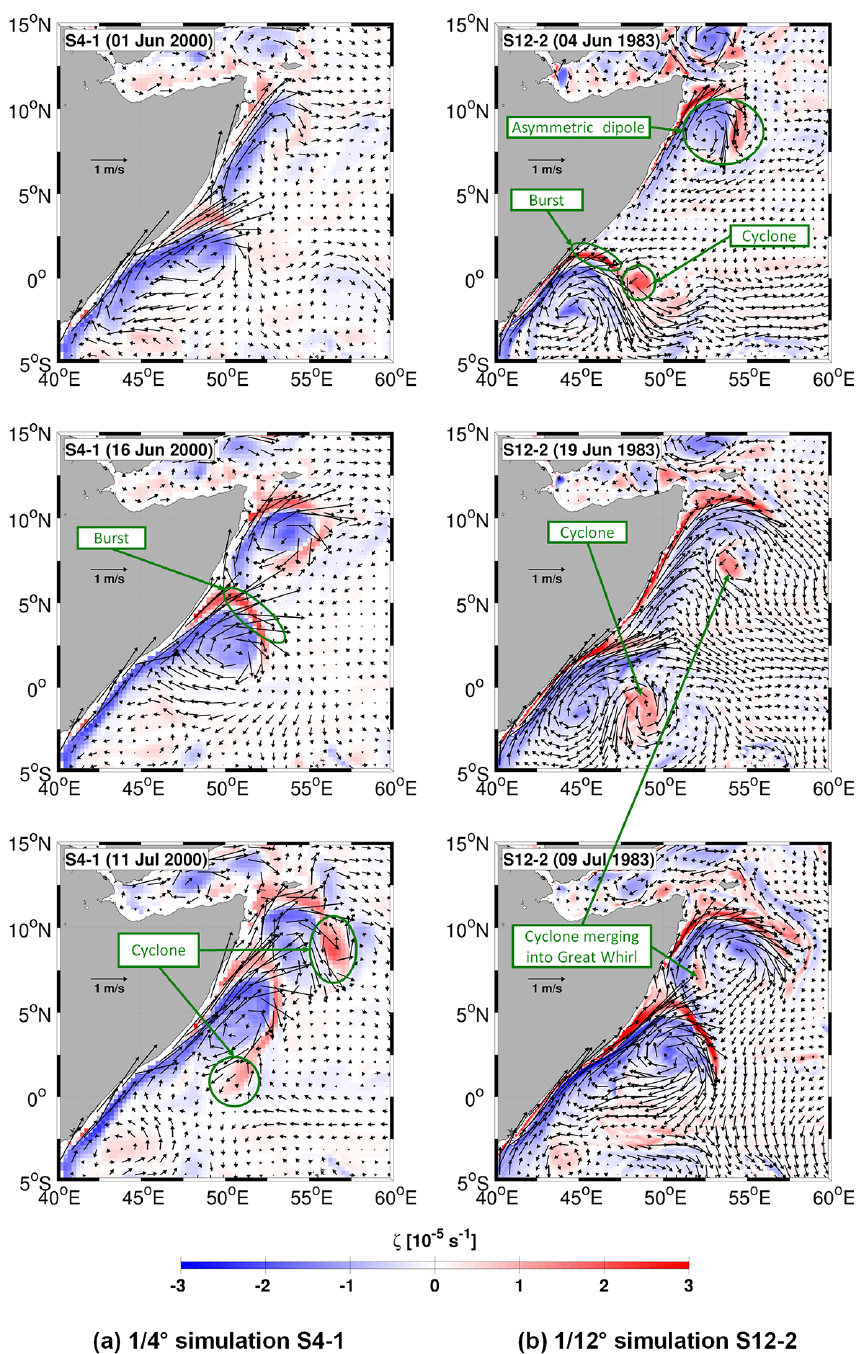
Figure 3. Sequence of relative vorticity ( ζ ; colour shading; s − 1 ) and currents (vectors; ms − 1 ) at 50m, (a) in the 1 / 4 ◦ S4-1 simulation, and (b) in the 1 / 12 ◦ S12-2 simulation. The sequences show the occurrence of the vorticity bursts and their subsequent development into asymmetric dipoles. The two large pools of negative (blue) vorticity are the SG and the GW. The bursts are the filaments of positive (red) vorticity, and the cyclones are the circular features of positive (red)